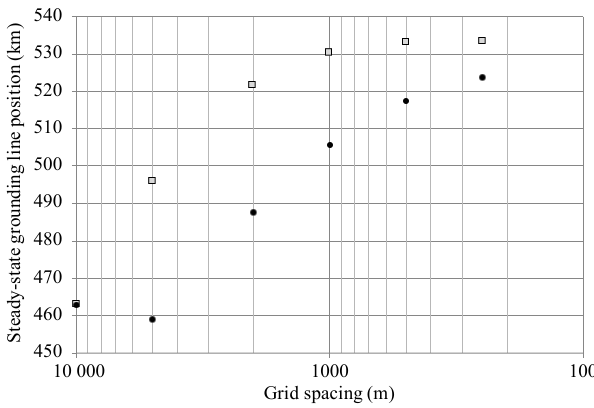
Figure 10. Grid resolution convergence for the MISMIP3d Stnd ex- periment with (gray squares) and without (black circles) grounding line